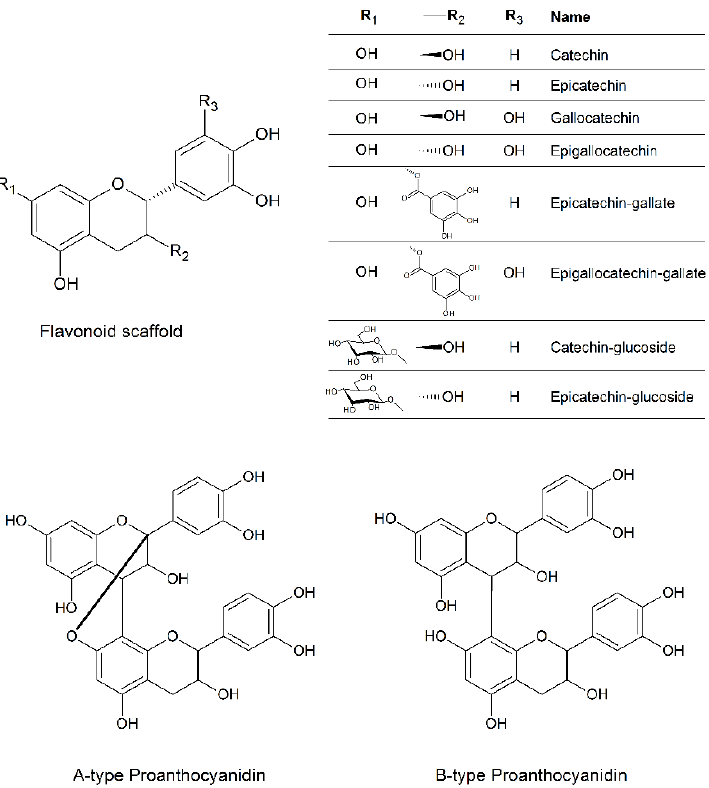
Figure 9. Chemical structure of the detected flavonoid and proanthocyanidin compounds in KLRE.